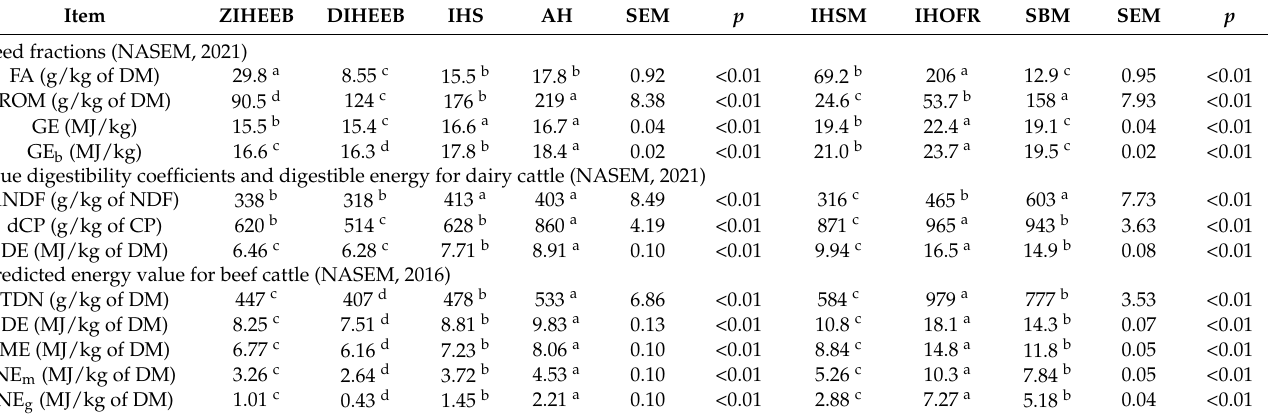
Table 5. The estimated digestible energy values of industrial hemp byproducts and conventional